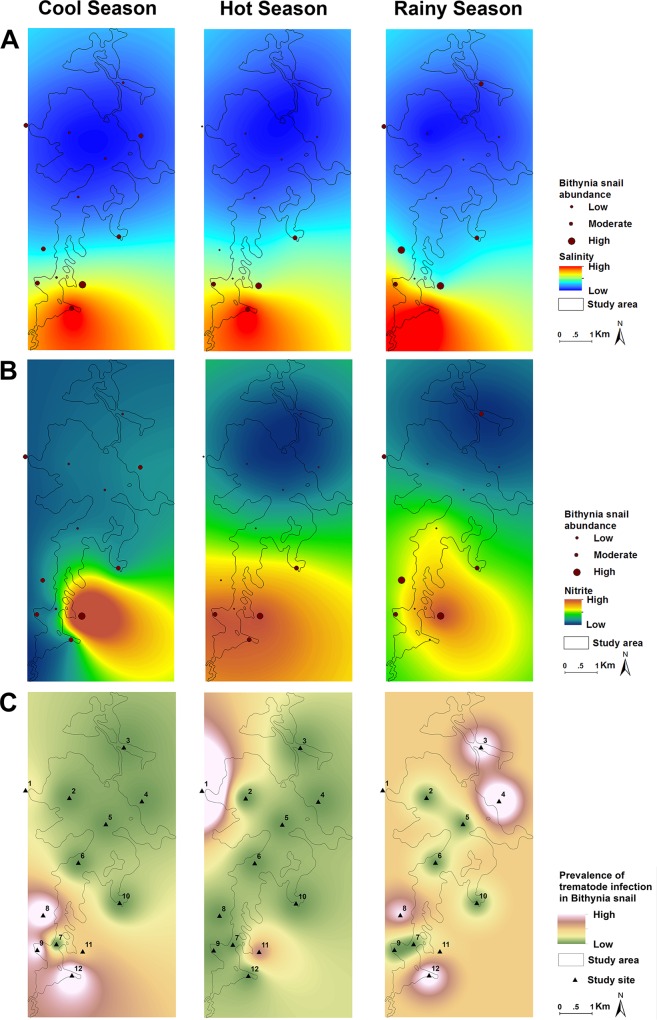
Kriging geographic analysis of the abundance of snails in relation to (A) salinity, (B) nitrite. Panel (C) shows the prevalence of infection of trematode cercariae in Bsg snails. Data for the rainy season, cool season and hot season is shown.